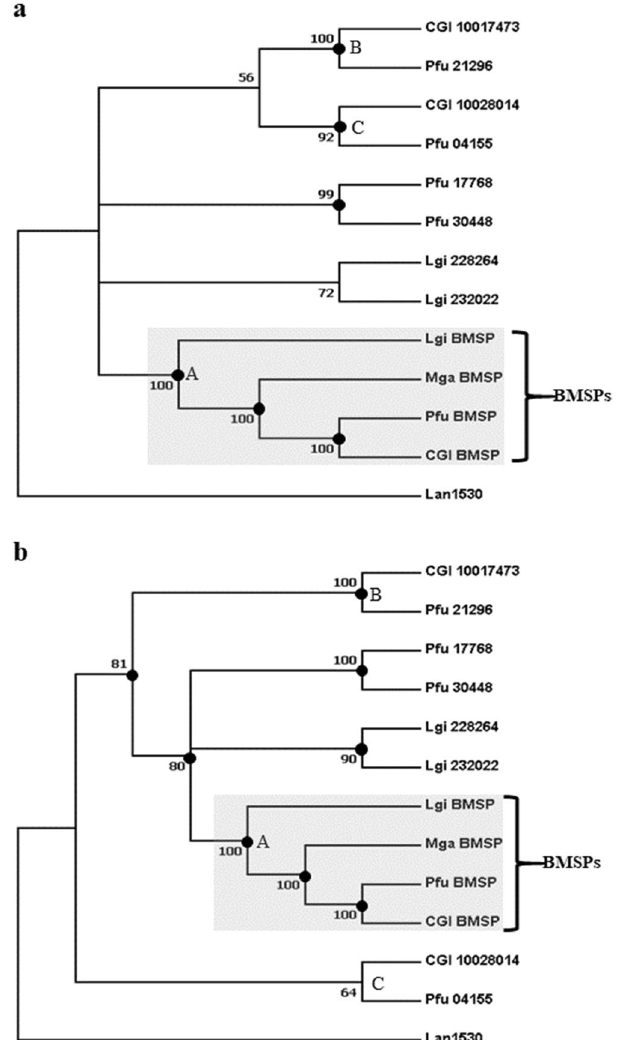
Figure 3. Phylogenetic analyses of Laminin G domains on 210 amino acids and the concatenated sequence of a CB domain and the Laminin G domain on 282 amino acids of VWA-CB dcps of molluscan shells. ( a ) A Bayesian phylogenetic tree based on Laminin G domains. ( b ) A Bayesian phylogenetic tree based on concatenated sequences of the CB and Laminin G domains. Polychotomy is generated if the posterior probability of the node is < 50. Posterior probabilities are shown if ≥ 50, and marked with black dots if ≥ 80. Cgi, Crassostrea gigas ; Pfu, Pinctada fucata ; Mga, Mytilus galloprovincialis ; Lgi, Lottia gigantea ; Lan, Lingula anatina . The group formed by BMSPs is